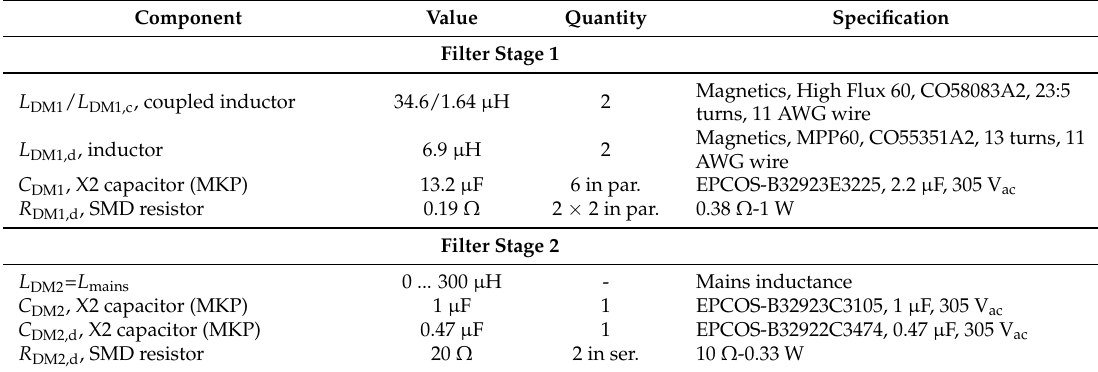
Table A9. Differential mode (DM) EMC input filter components.